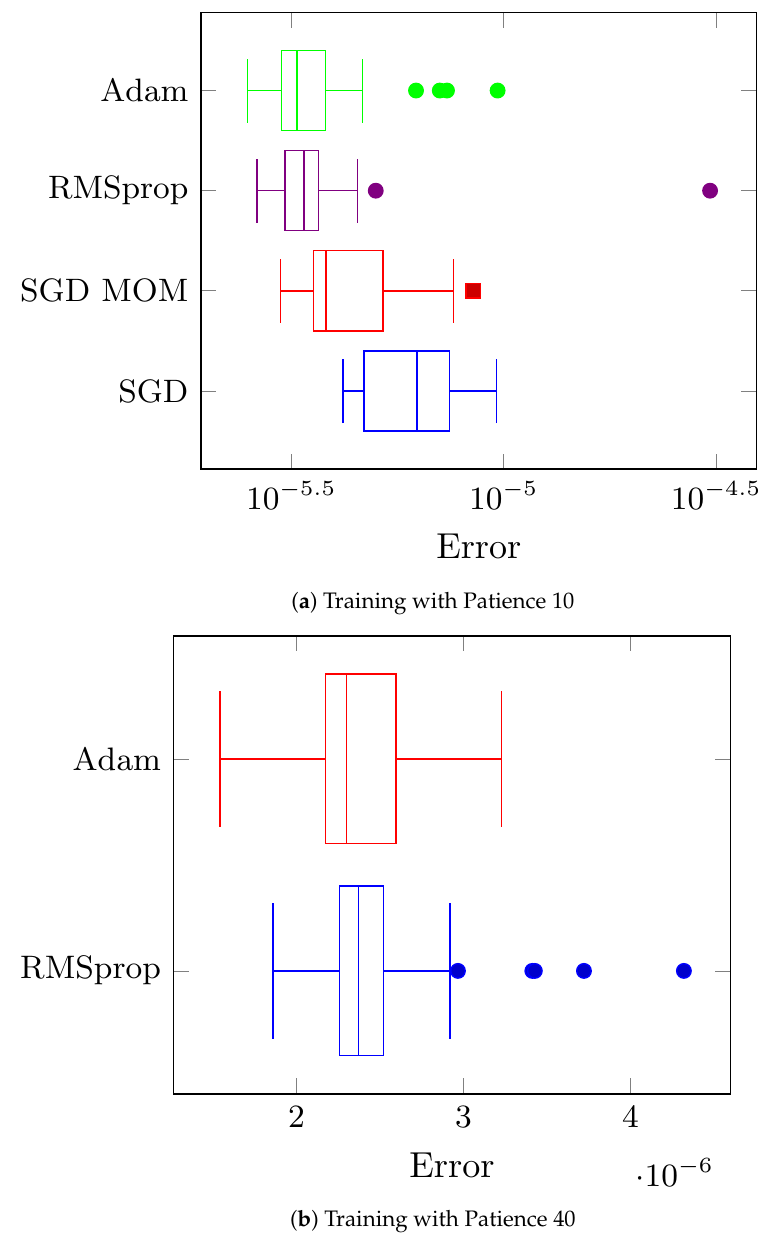
Figure 10. Comparison of errors for different